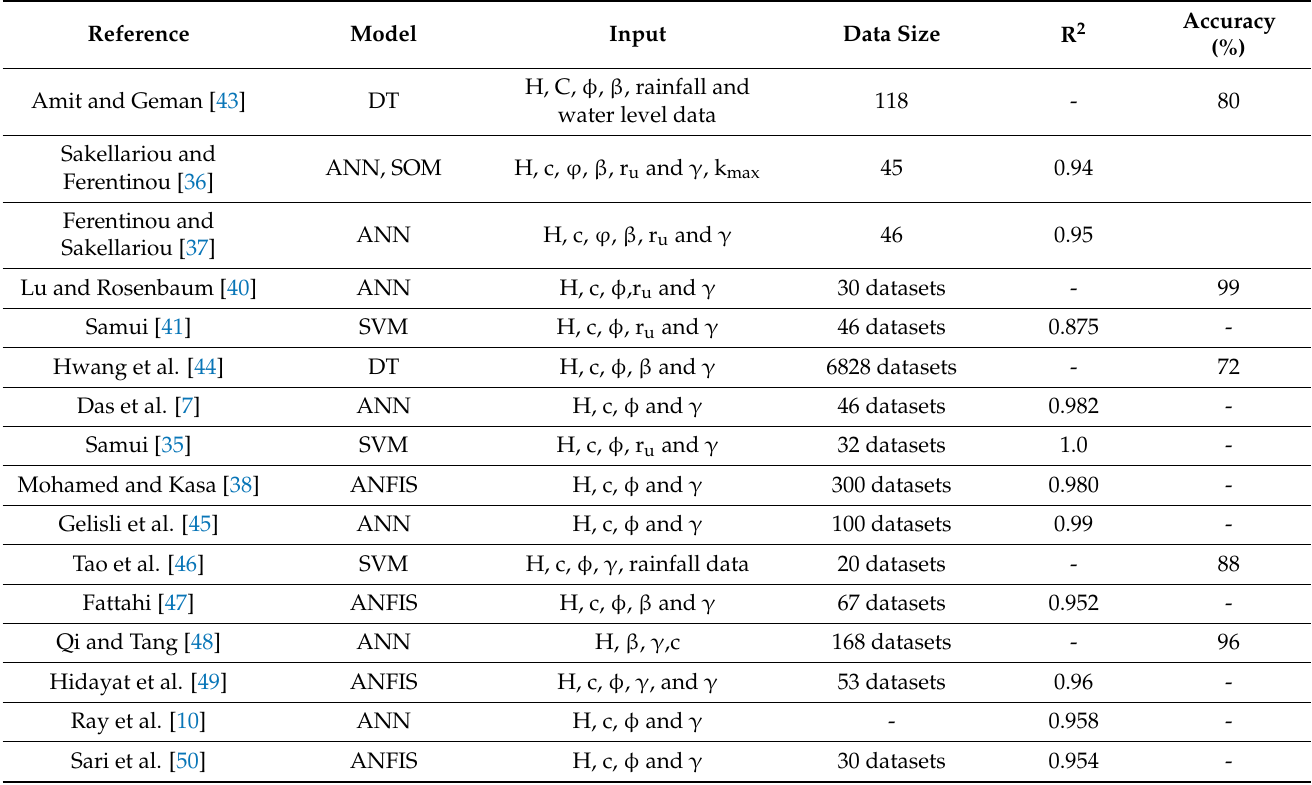
Table 1. Some of the classifications/prediction studies in the areas of slope stability using AI/ML models.